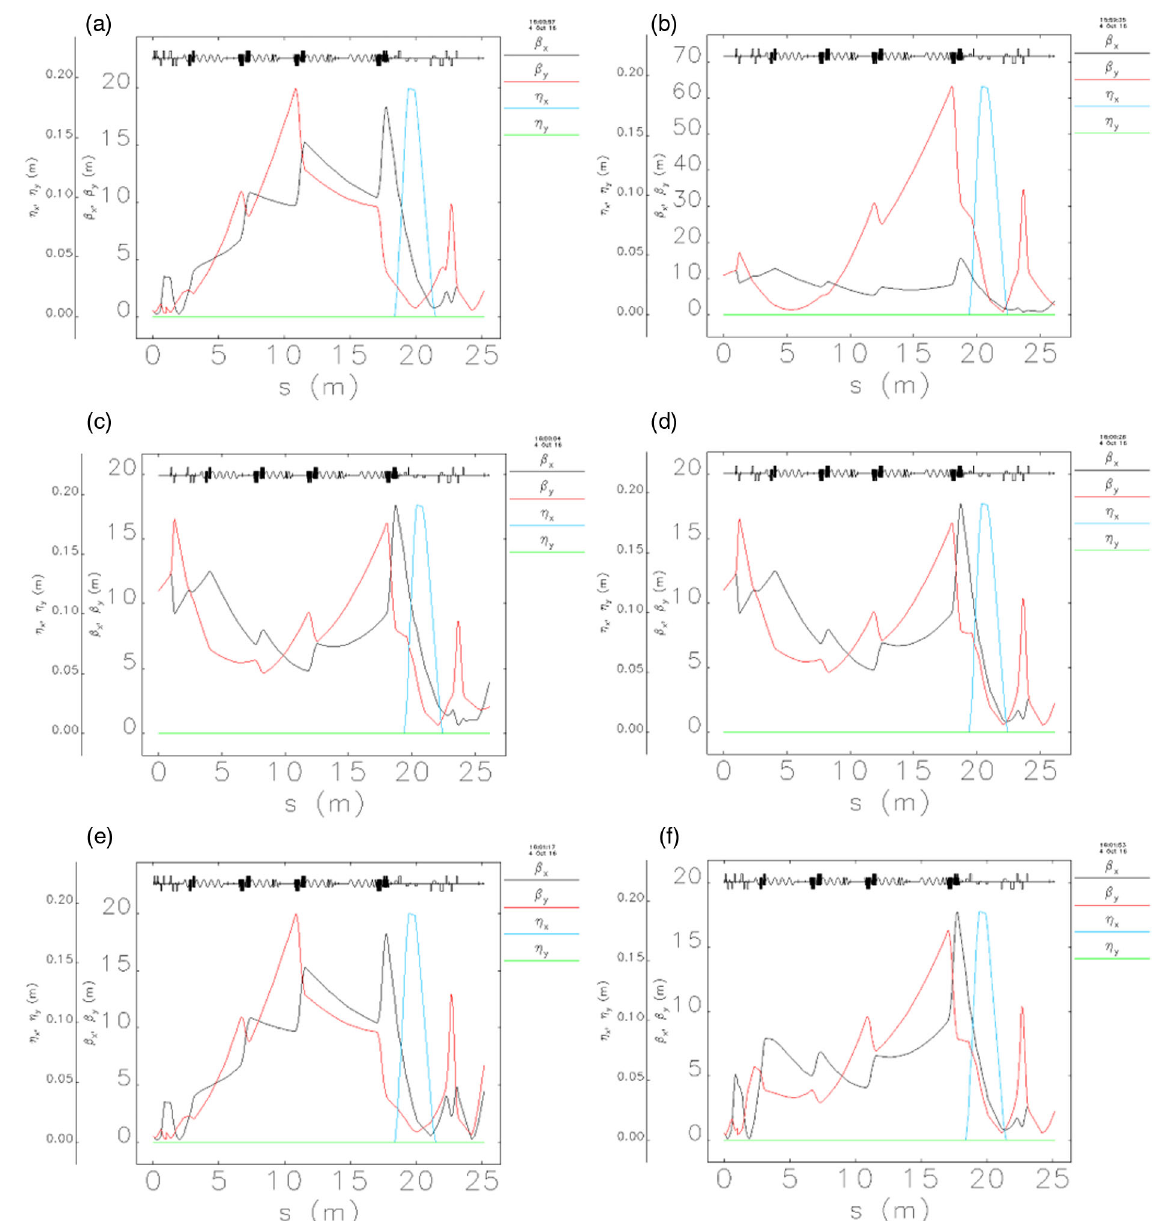
FIG. 7. The results along the process of interleaving lattice design. (a) RG beam optimization. (b) PCG beam result by setting quadrupoles obtained in (a) to PCG. (c) PCG optimization using two initial dedicated quadrupoles for PCG. (d) PCG optimization using Q11 and 4Qs for emittance measurement. (e) RG beam result by setting Q11 and 4Qs obtained in (d) to RG. (f) RG optimization using four initial dedicated quadrupoles for